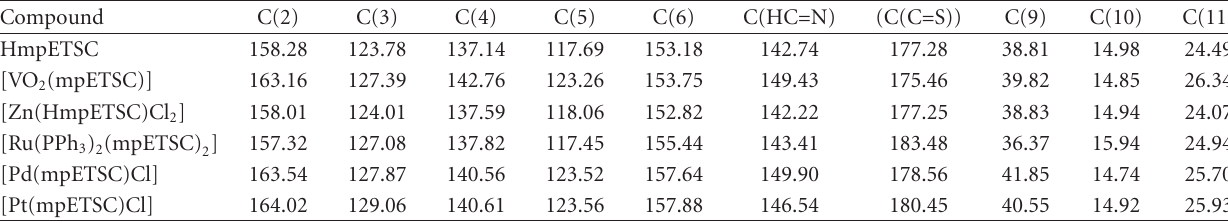
Table 4: 13 C-NMR spectral data of HmpETSC and its